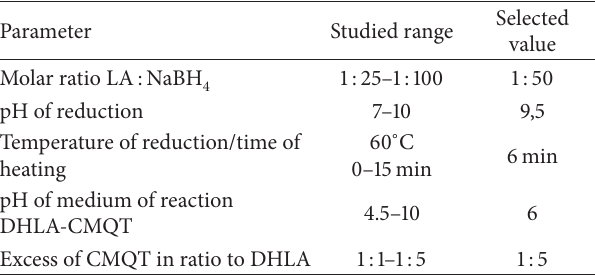
Table 1: Features of the developed methodology. Parameter Studied